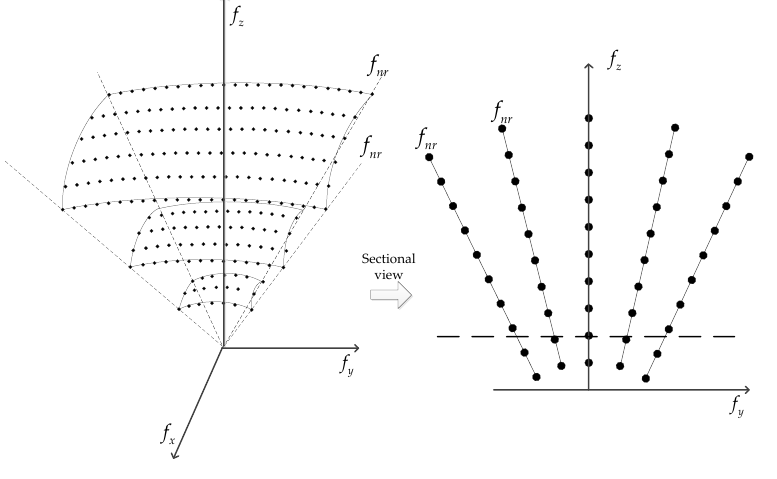
Figure 1. Spectrum support region.